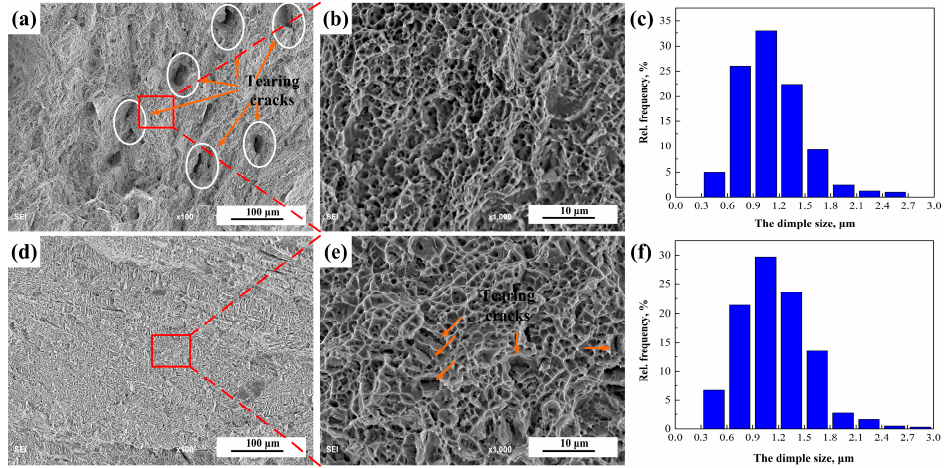
Figure18. Fracturemicrographsanddimplesizesofthetensilesamplesoftheweldedjoints: ( a – c )1670-8, Figure 18. Fracture micrographs and dimple sizes of the tensile samples of the welded joints: ( a – c ) ( d – f ) 1670-8, ( d – f ) 1670-14.